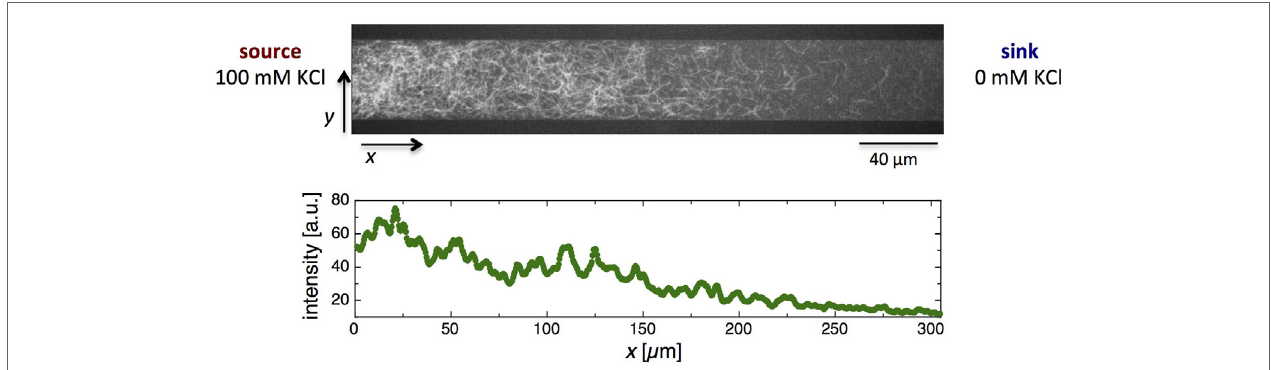
FigUre 3 | Fluorescence micrograph of actin filament assembly in a Kcl gradient over a rectangular microchannel (top panel) . The density of the entangled actin filaments decreases with decreasing KCl concentration. In the bottom panel, the decrease in F-actin density is represented as a plot of the averaged fluorescence intensity against the distance from the source, x